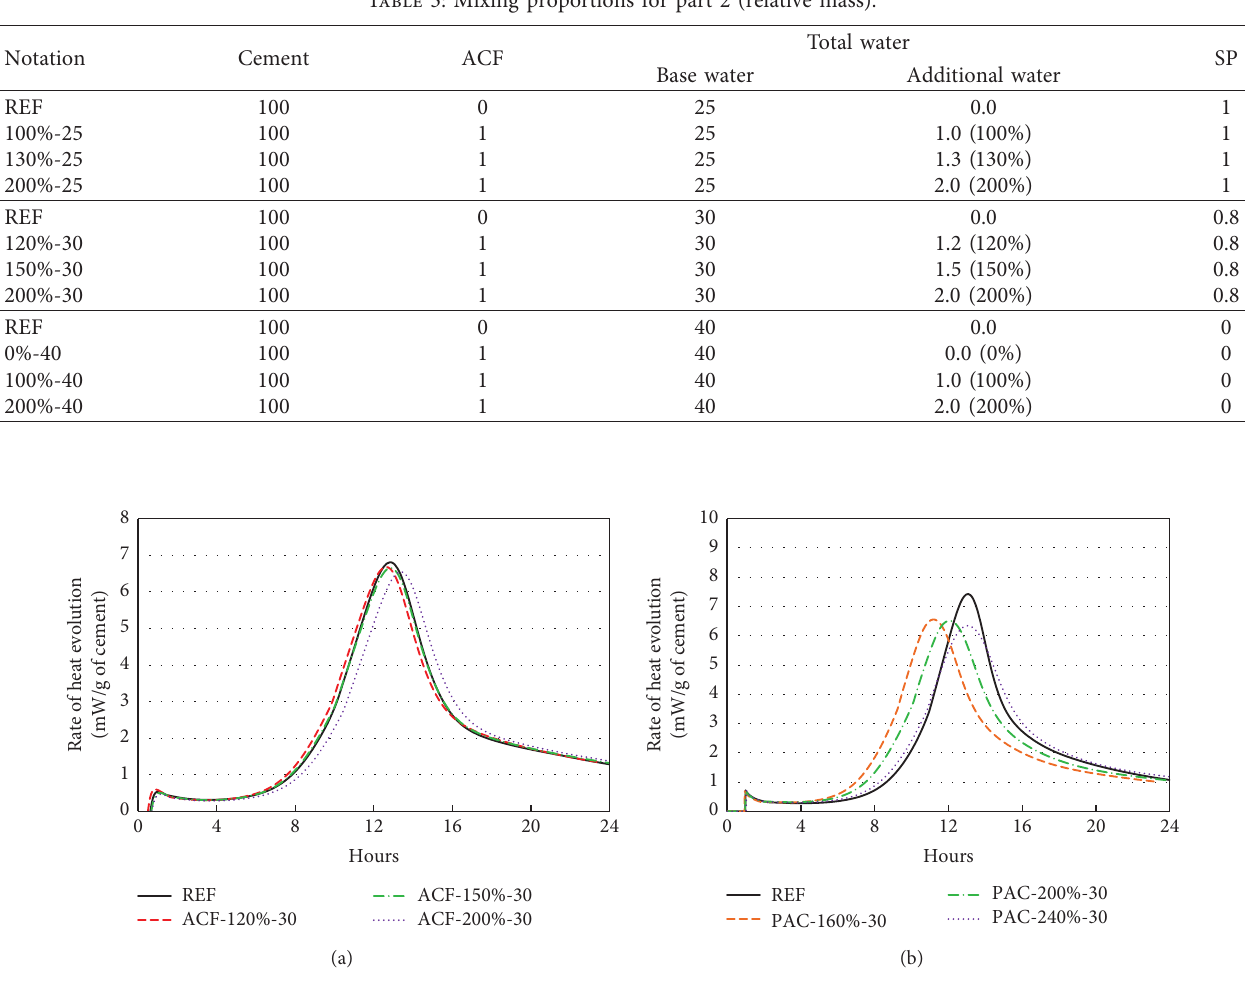
Figure 3: Rate of hydration curves of cement pastes: (a) REF- and ACF-containing cement pastes with 120%, 150%, and 200% additional water; (b) REF- and PAC-containing cement pastes with 160%, 200%, and 240% additional